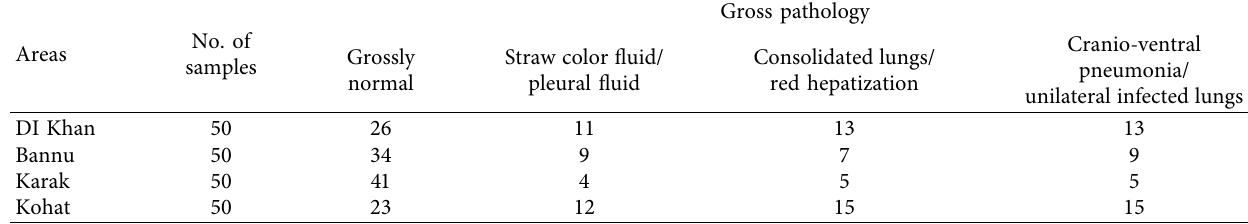
Table 6: Occurrence of gross pathological lesions in the thoracic cavity in naturally infected goats. No. of Areas